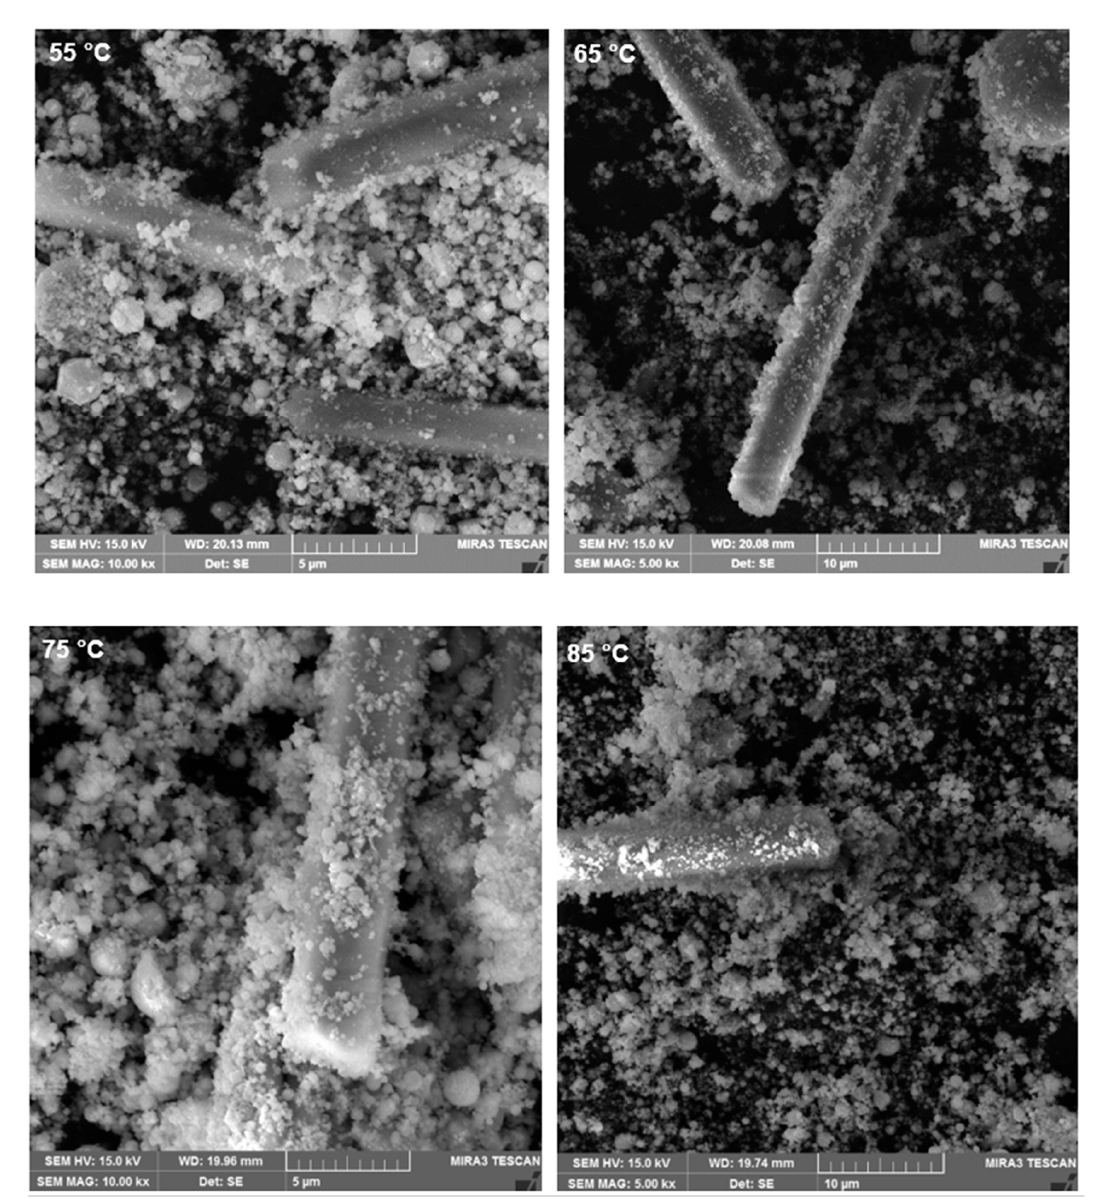
Figure 20. SEM images of the EAFD residue after leaching in 30% v/v [Bmim + HSO 4 − ] solution at different temperatures (55 to 85 °C).